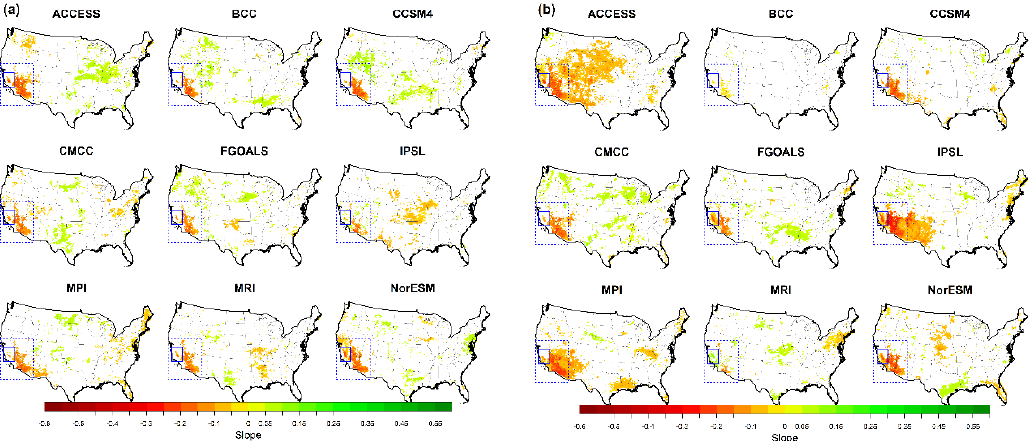
Figure 4. Spatial–temporal trends of drought occurrence for the historical ( a ) and projected periods ( b ). Dotted blue box shows a region of comparable trend among the models. The solid black box shows a small, isolated region in middle California.